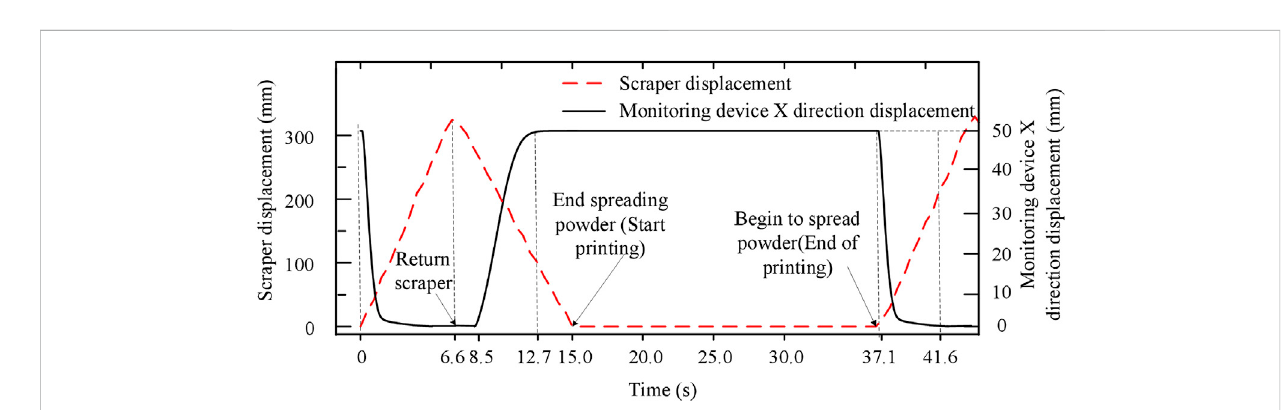
FIGURE 15 Displacement response curves of scraper and monitoring device during collaborative